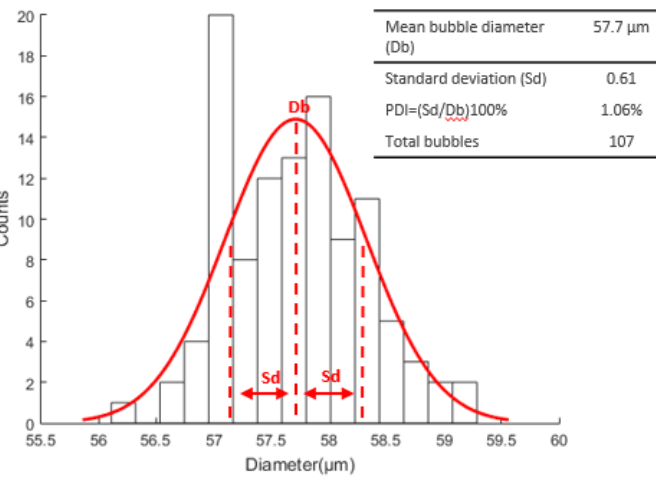
Figure 3. Microbubble diameter distribution curve using a MBB-BP-L-30 micropipette.